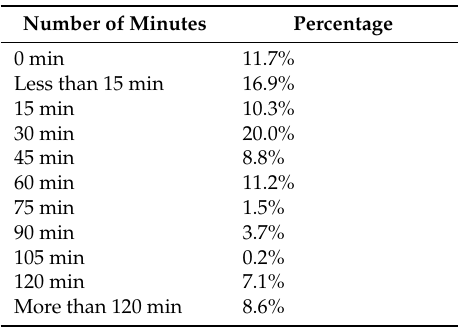
Table 4. Time spent preparing to leave (n =